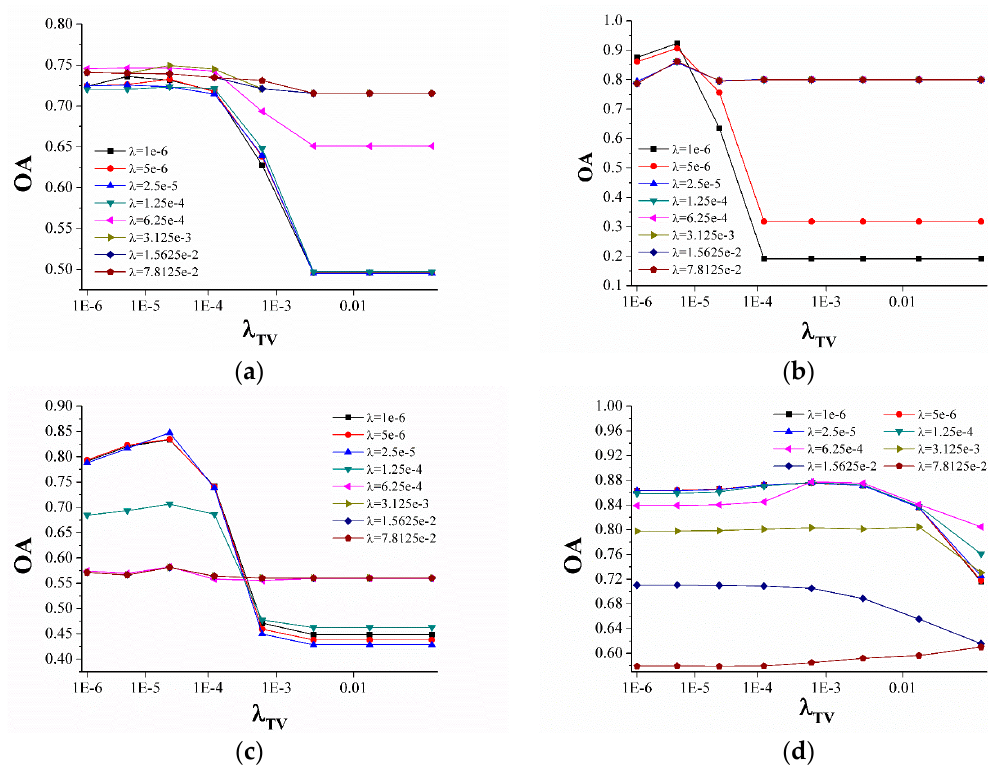
Figure 8. A comparison of the performance of the proposed method with different regularization parameters settings for all our experiments: ( a ) Synthetic HJ-1A image; ( b ) Synthetic FLC1 image; ( c ) Synthetic Indian Pines dataset; ( d ) Real Nuance dataset.